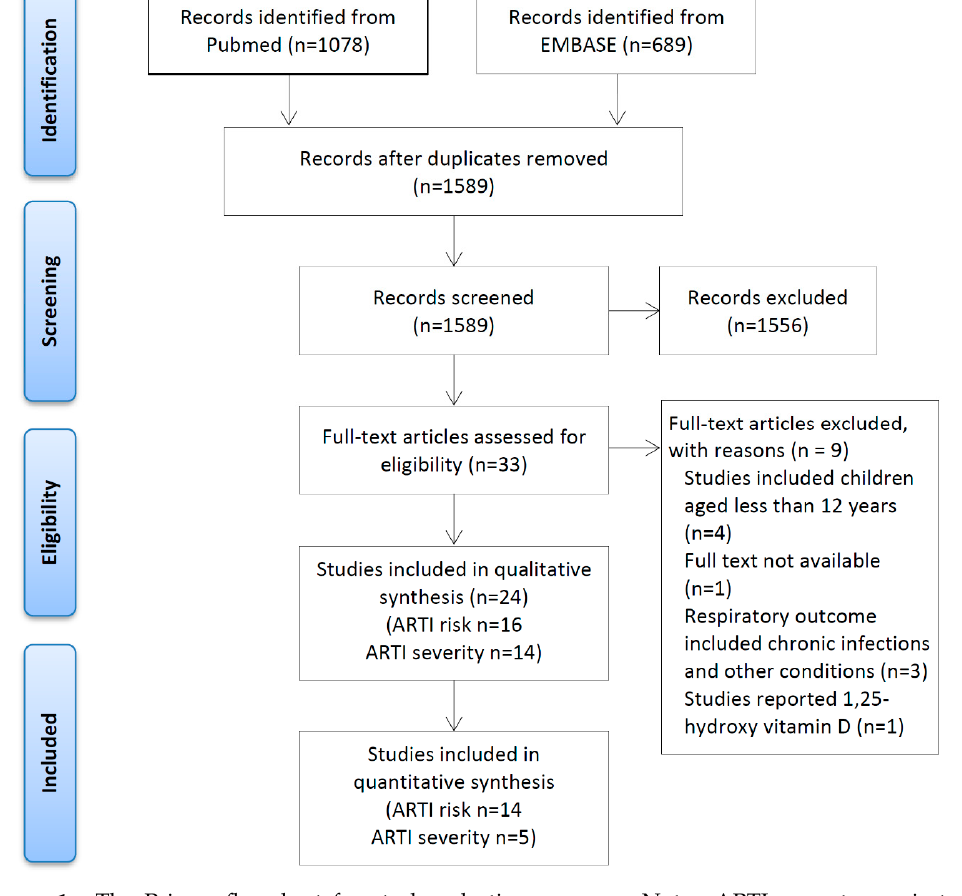
Figure 1. The Prisma flowchart for study selection process. Note: ARTI = acute respiratory tract infection.